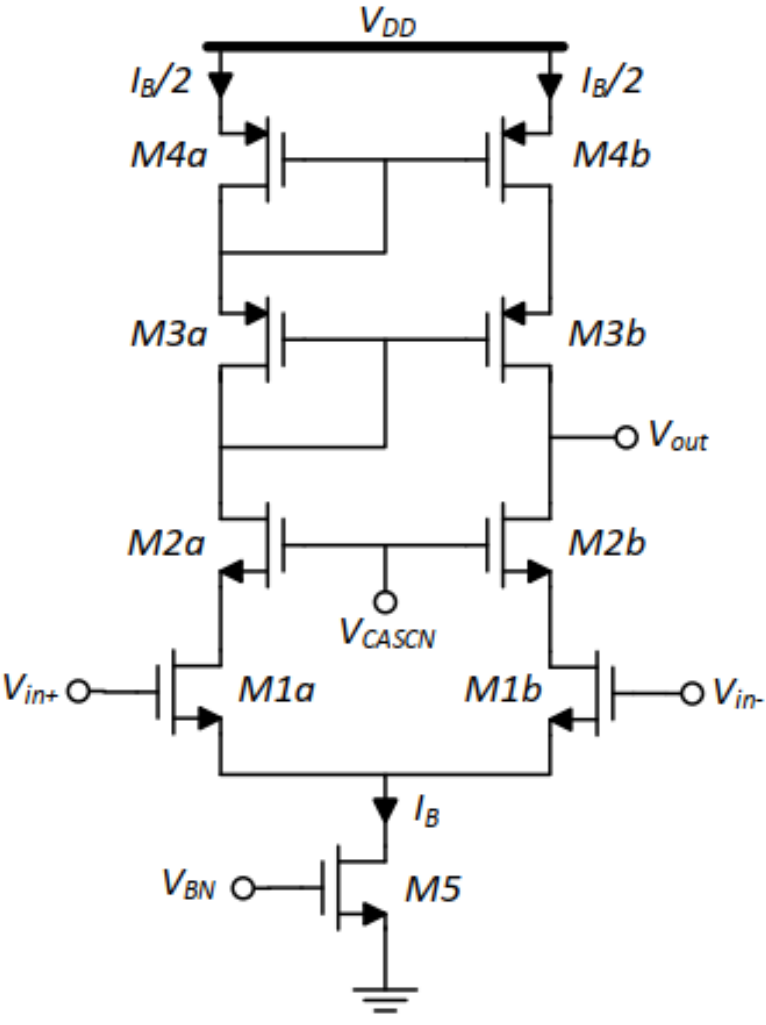
Figure 3. Schematic of the predicted topology used as a design example.